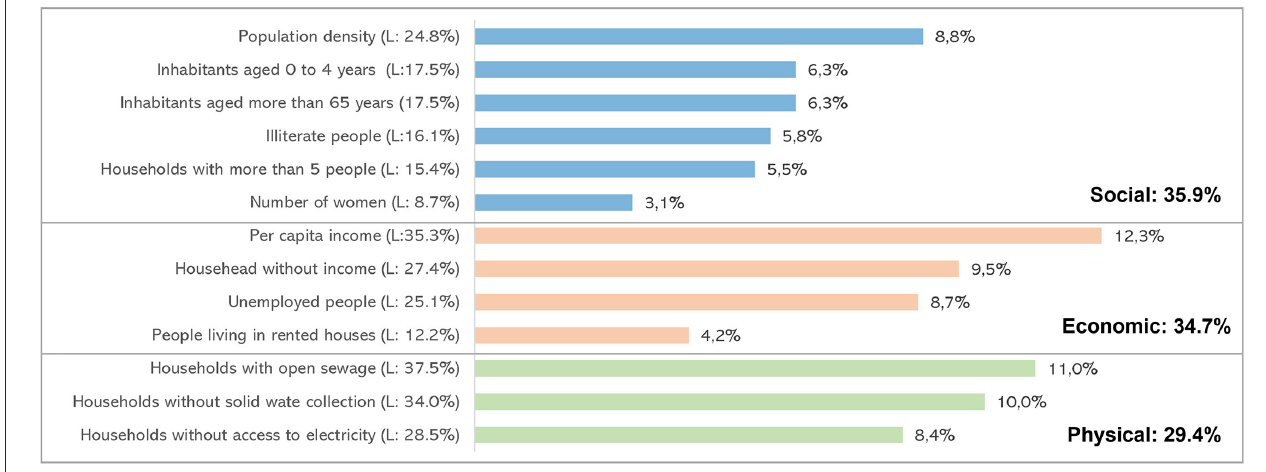
FIGURE5 Global weights in percentage (indicator importance considering the weights attributed to social, economic, and physical categories). The color blue represents the social vulnerability category, orange is the economic, and green is the physical. The local weights (indicator importance within each category) are denoted by “L”.